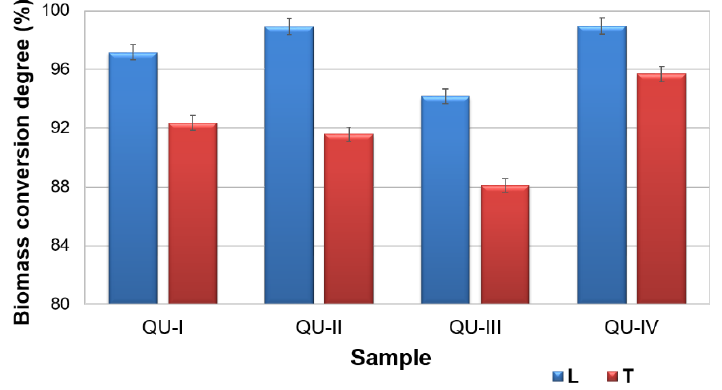
Figure 6. Biomass conversion degree (L—laboratory scale; T—technical scale).